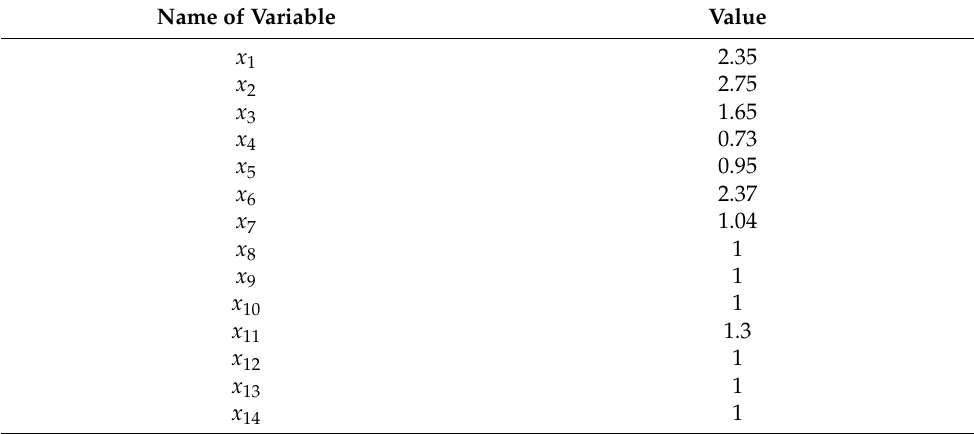
Table 1. The initialization of